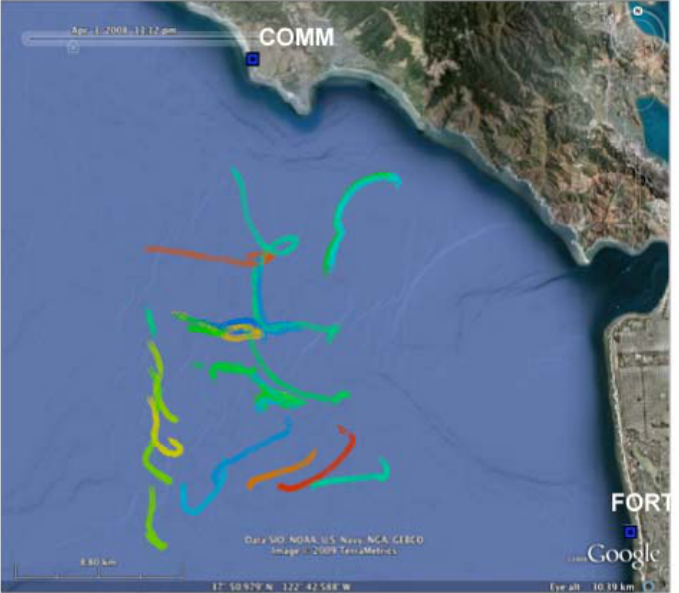
Figure 7. Drifter tracks recorded from April 1, 2008 14:20 to 18:40 showing the currents veering from an easterly to a westerly